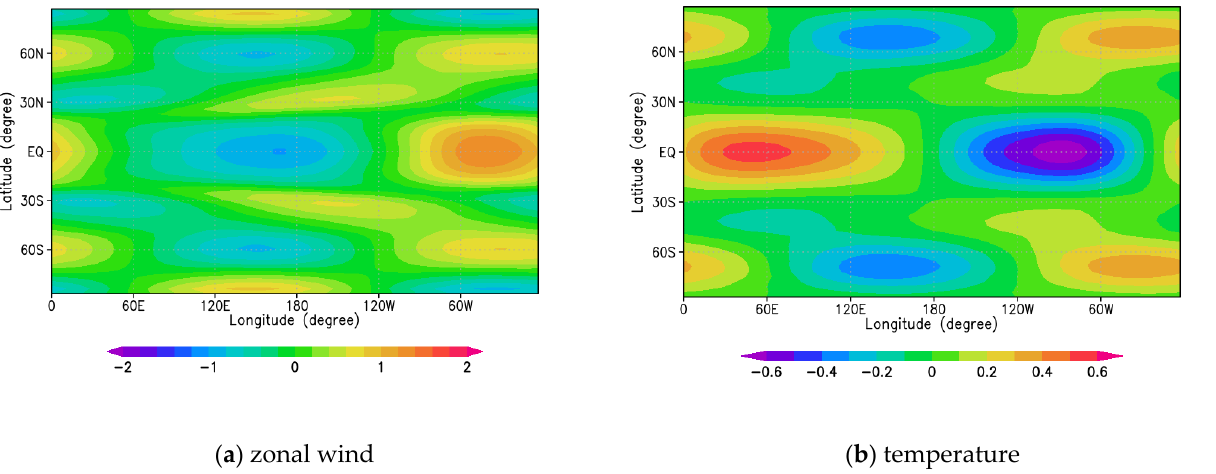
Figure A2. Longitude – latitude cross-sections of ( a ) zonal wind (m/s) and ( b ) temperature (K) deviation from their zonal averages on 1 January, 5th year.